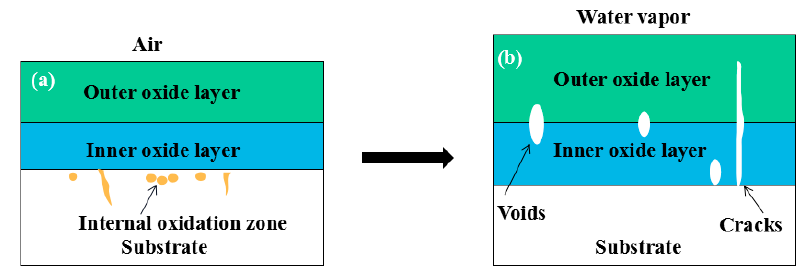
Figure 8. Schematic diagram of the oxide layer of Fe–10Cr steel in ( a ) air; ( b ) air + 50% water va- por.